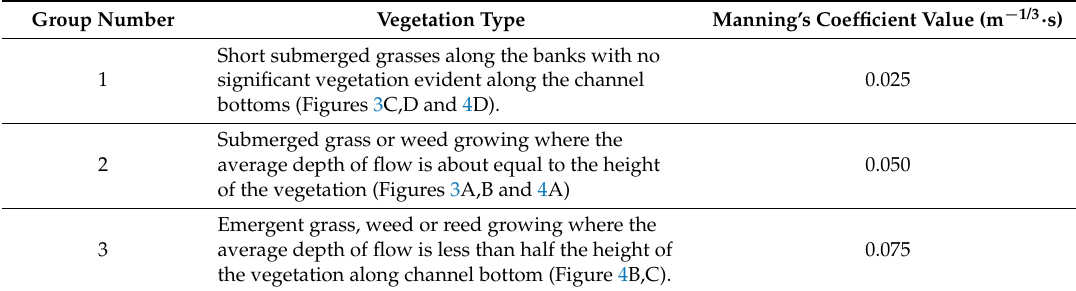
Table 2. Vegetation groups with Manning’s coefficient